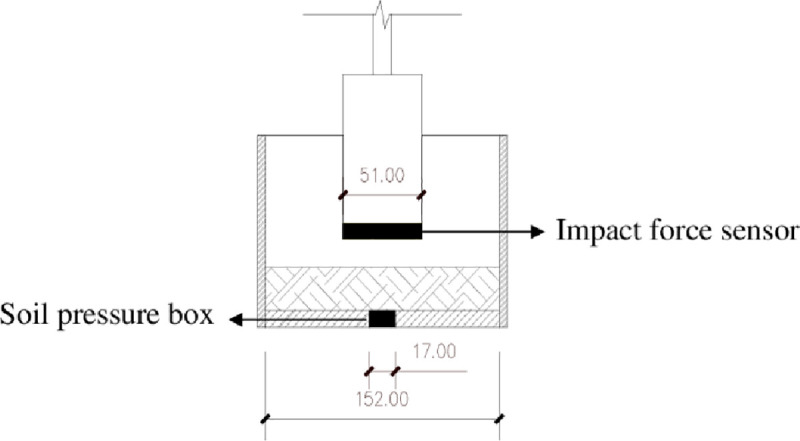
System connection diagram.